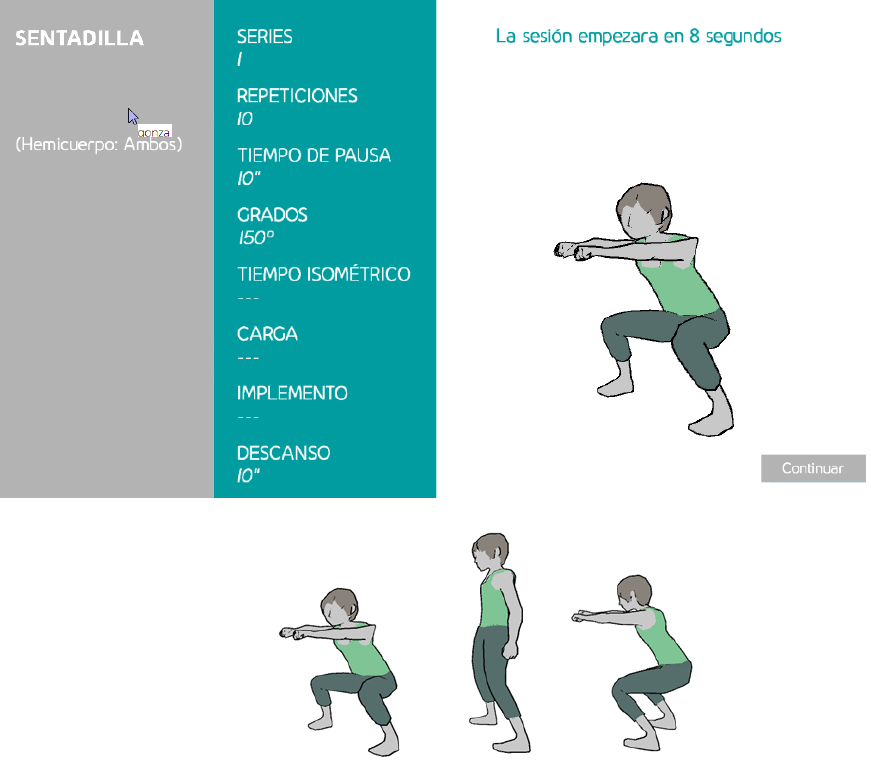
Figure 5. A 3D avatar illustrating how to perform the squat exercise. In the top, the screen with the scheduled exercise. In the bottom, some shots of the avatar motion sequence. scheduled exercise. In the bottom, some shots of the avatar motion